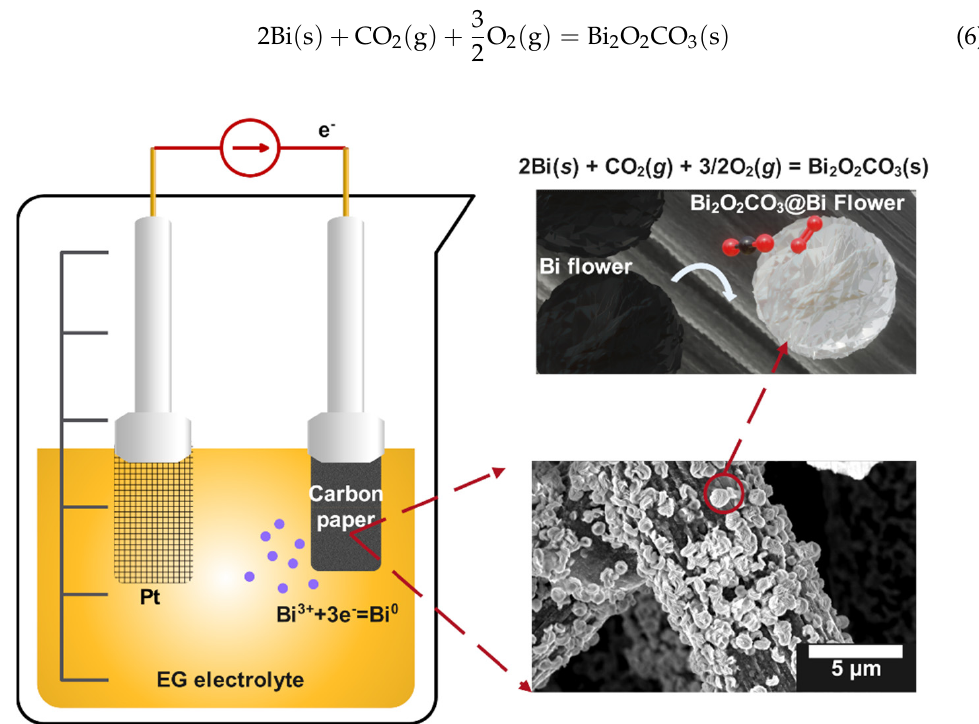
Schematic reaction mechanism of Bi 3+ reduction and formation of